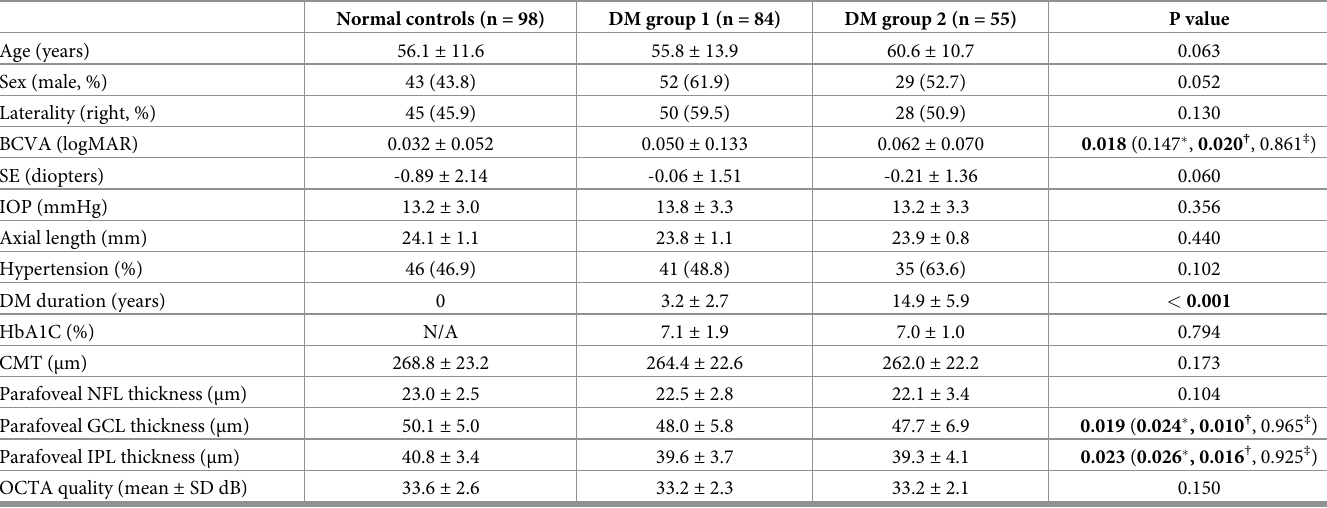
Table 1. Demographics and clinical